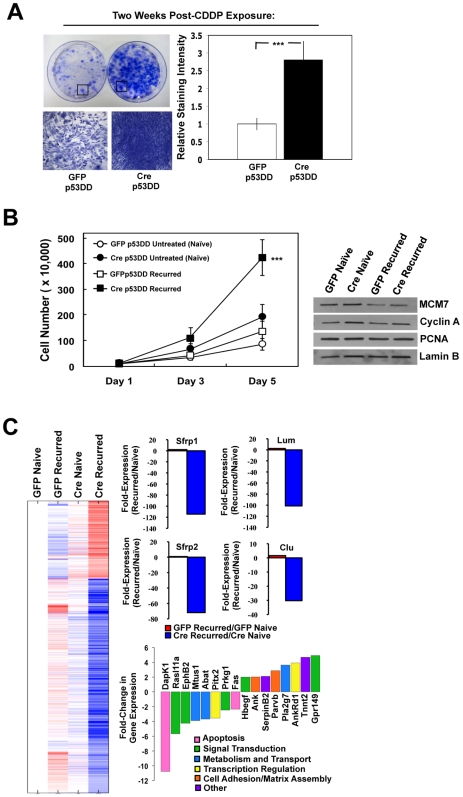
RB loss promotes aggressive recovery from therapy-induced damage and significant alterations in gene expression.(A) Cells were treated with 1 uM CDDP for 24 h, allowed to recover in fresh media, and stained with crystal violet two weeks post-treatment. Relative staining intensities from six independent experiments were quantified. ***p<0.0001 (B) Left, cells were cultured in normal growth media, and viable cells were counted over a course of 5 days. ***p<0.0001 Right, total protein lysates were immunoblotted for the indicated proteins. Lamin B served as a loading control. (C) Gene expression data was averaged for each cell line and normalized to the RB-proficient p53DD, untreated cell population (GFP Naïve). Left, changes in gene expression are displayed as a heat map. Right, those genes with specific involvement in transformation are highlighted in bar graphs. Gene expression values are displayed as fold-change in gene expression.